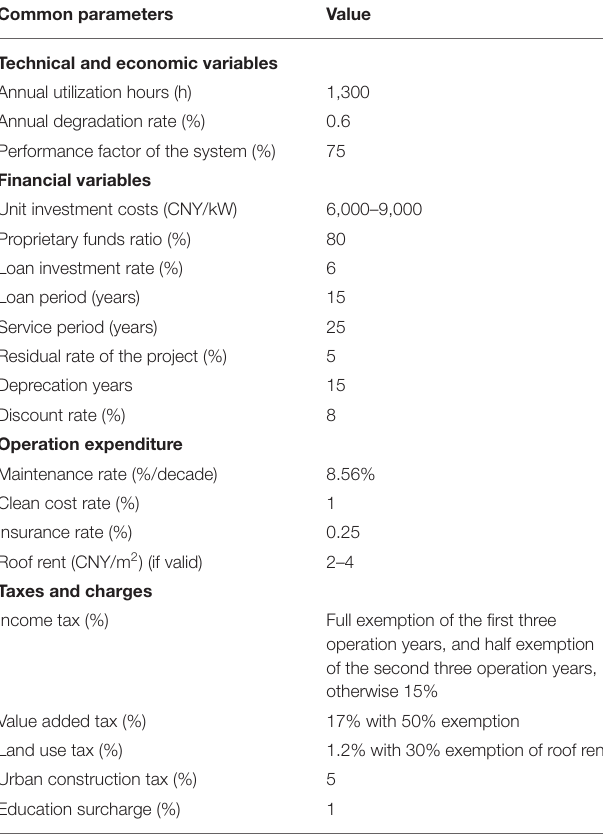
TABLE 4 | IRR of commercial and residential rooftop PV in the baseline scenario.